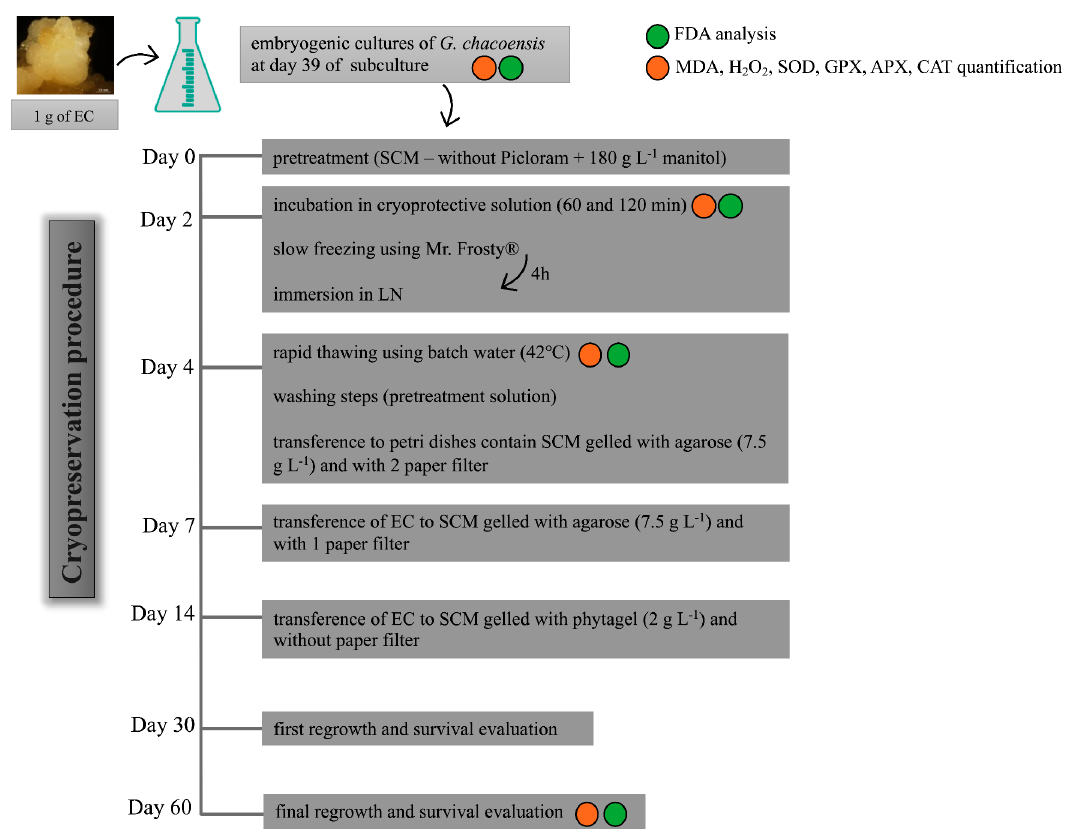
Figure 7. Cryopreservation procedure used for embryogenic cultures of G. chacoensis, described step-by-step. EC: embryogenic culture; SCM: suspension culture medium; FDA: Fluorescein diacetate; MDA: malonaldehyde; H 2 O 2 : hydrogen peroxide; SOD: superoxide dismutase; CAT: catalase; APX: ascorbate peroxidase; and GPX: guaiacol peroxidase. Circles in green and orange identify the steps during which FDA analysis and enzymes analysis were realized,